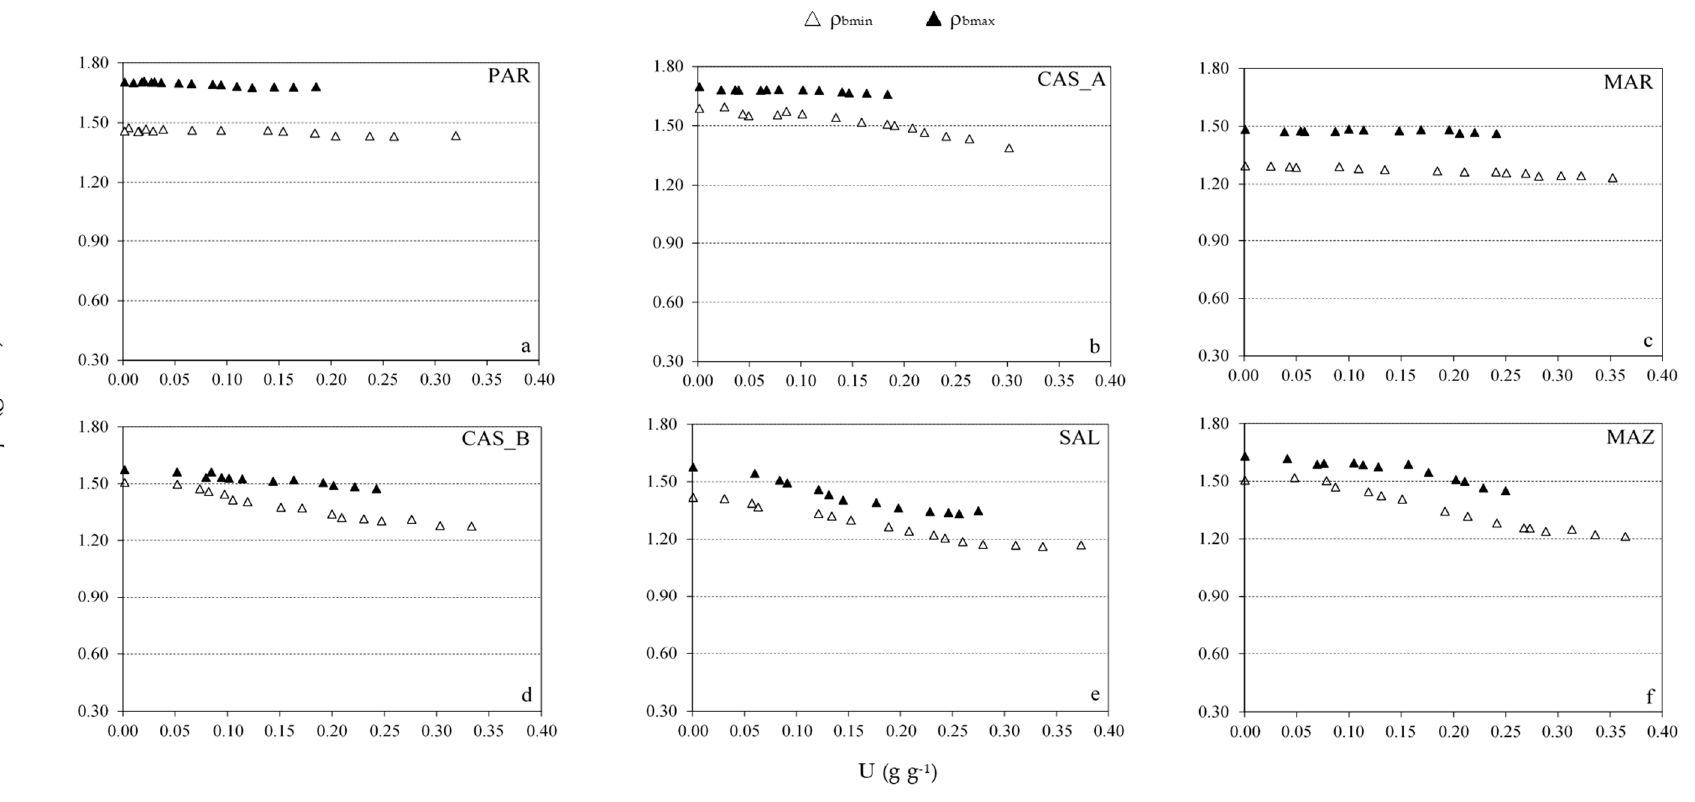
Figure 2. Relationships of soil bulk density as a function of gravimetric water content, ρ b (U), measured during the air-drying process on repacked monoliths, at maximum ( ▲ ) and minimum ( ) soil bulk density. ( a ) PAR, ( b ) CAS_A, ( c ) MAR, ( d ) CAS_B, ( e ) SAL and ( f ) MAZ.